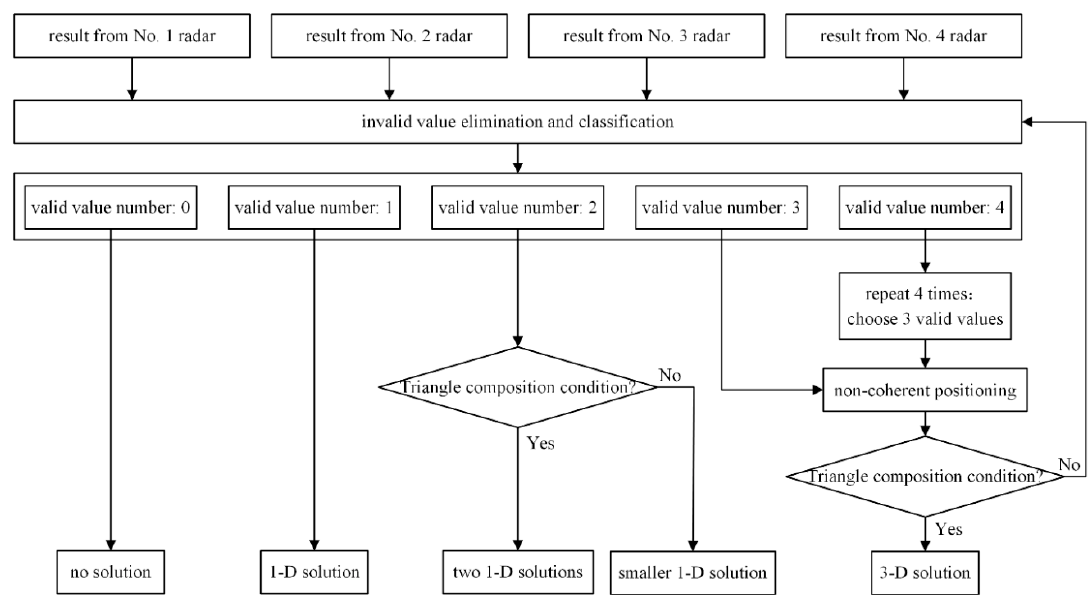
Figure 5. The vital sign searching procedure.